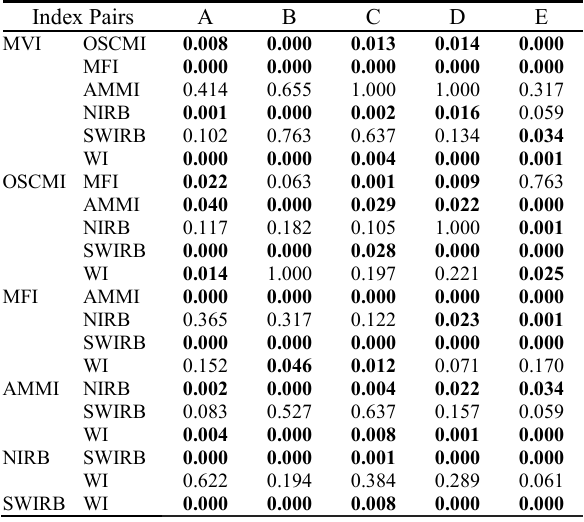
Table 6. McNemar Test p-values between all index pairs. Bold values signify significantly different extraction results (at p